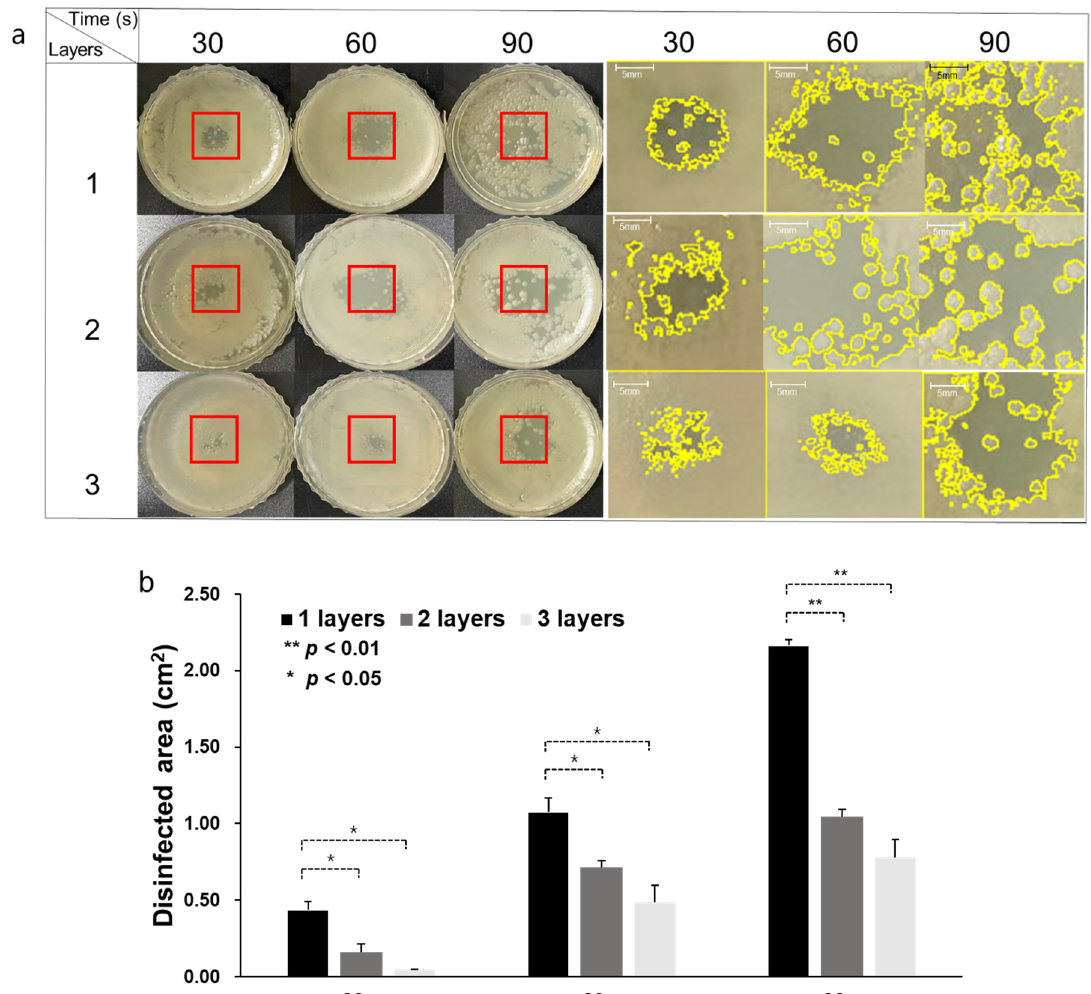
Figure 6. CAPMP treatment on S. aureus spread on the agar plate covered by single, double, or triple gauze layers. ( a ) Disinfected clear zone on the S. aureus agar plate, indicated by the zoomed-in red ROI shown on the right columns, with yellow lines indicating the zone boundary. ( b ) Average and standard deviation of the disinfected area analyzed using ImageJ, according to the number of gauze layers and CAPMP treatment time ( n = 3). *: p < 0.05, **: p < 0.01 by t -test between the